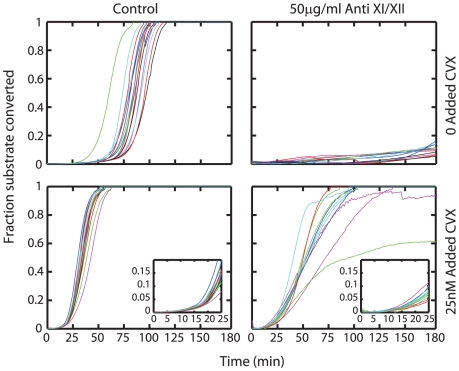
Effect of anti-XI and anti-XII.Addition of 50 µg/ml of anti-XI and anti-XII will completely prevent initiation of clotting in resting blood showing that initiation is a result of leak past saturated effects of CTI. However, on CVX activated platelets initiation is still unaffected by the presence of both CTI and these antibodies. Initial thrombin production during the propagation phase is however diminished due to abolition of thrombin feedback on FXI. Insert shows initial rates of thrombin formation in the presence of these antibodies.